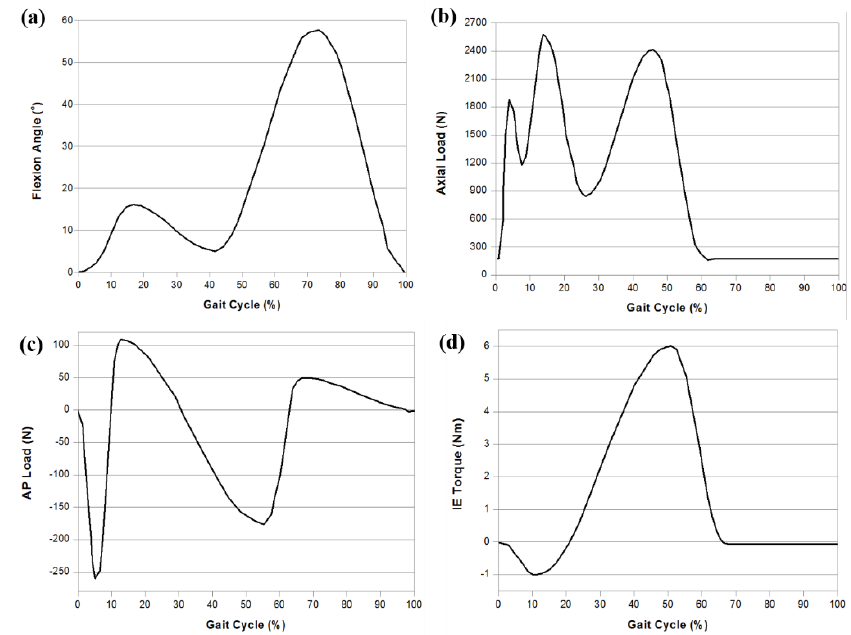
Figure 3. Gait cycle input function for the finite-element (FE) model: ( a ) flexion angle; ( b ) axial load, ( c ) anterior/posterior (AP) load; ( d ) internal/external (IE) torque.